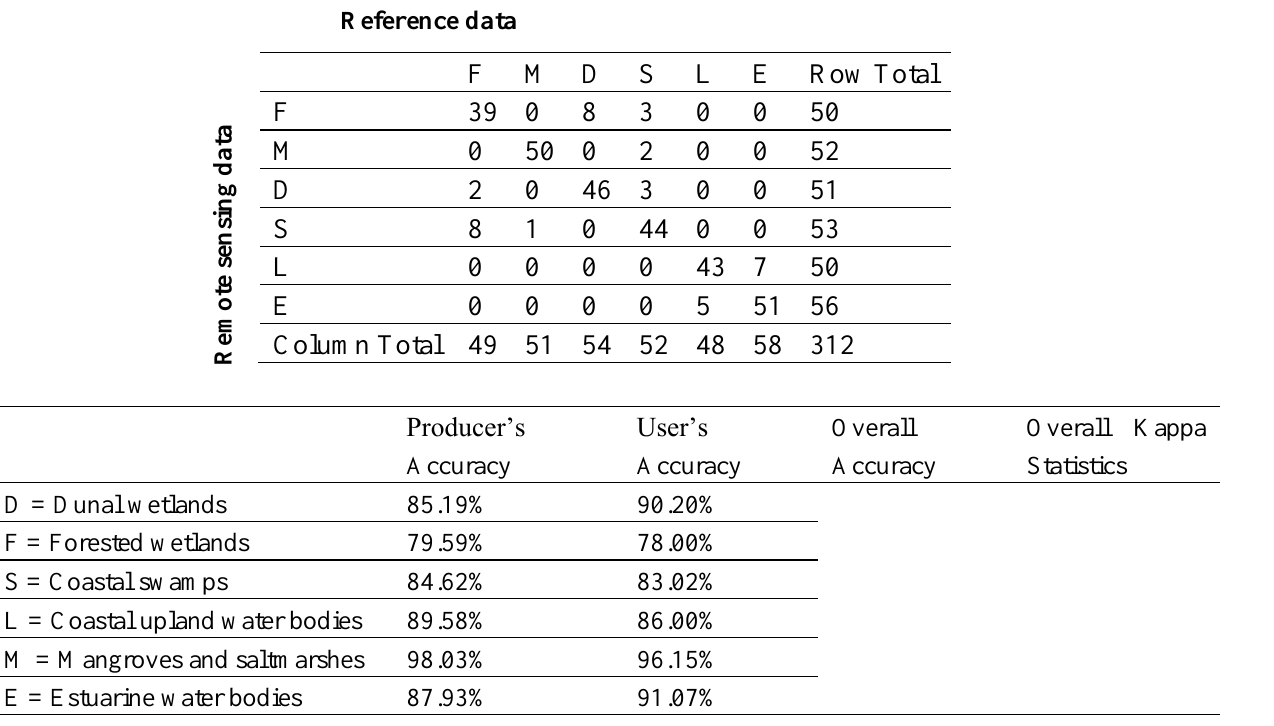
Table 7. Error Matrix Table for Landsat TM + 2001 wetland